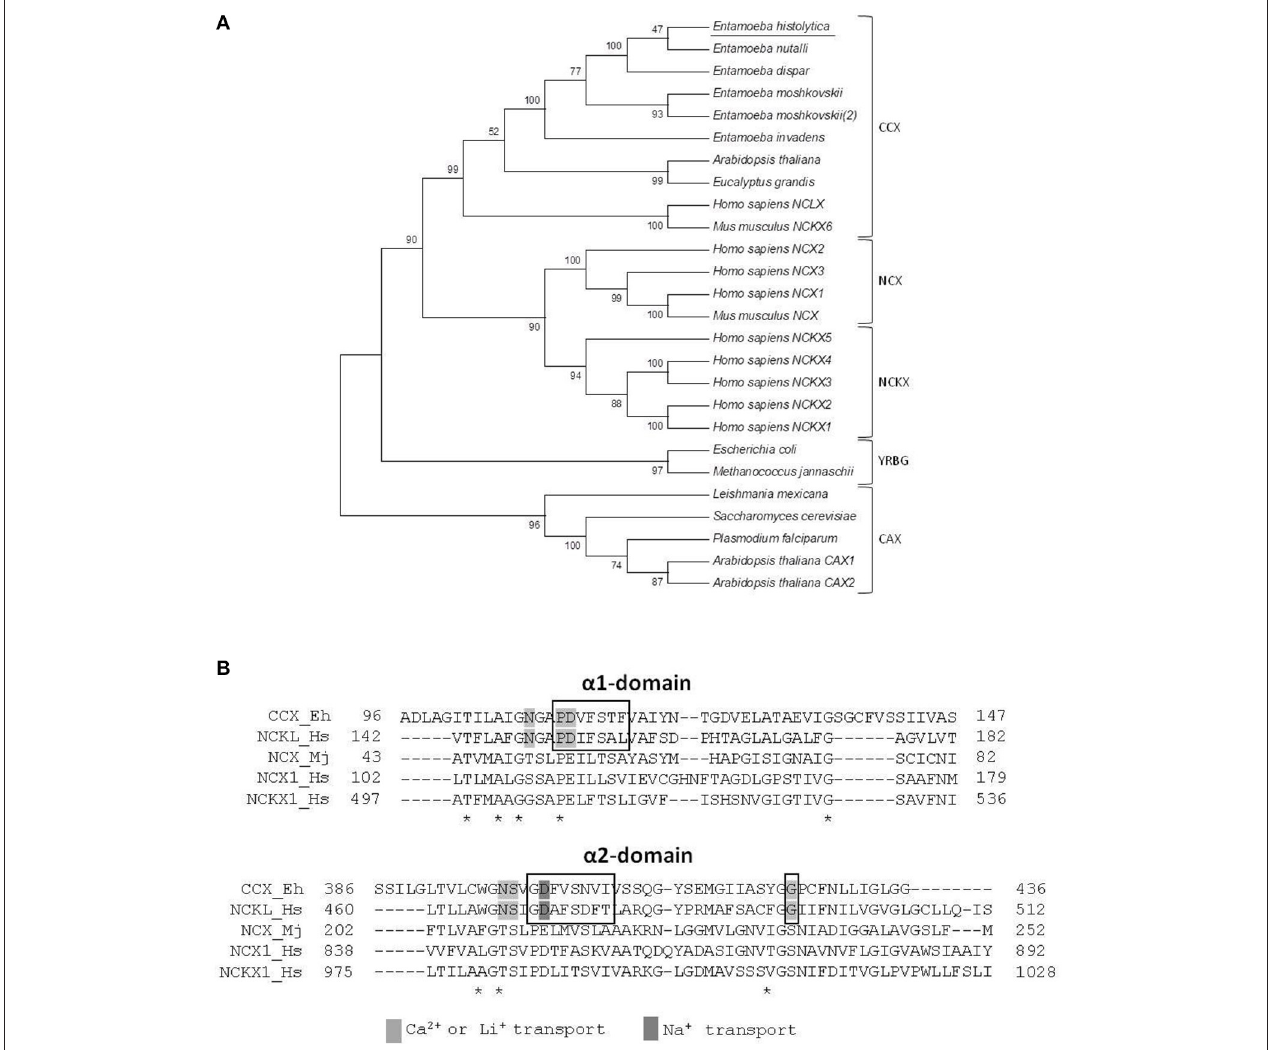
FIGURE 2 | Phylogenetic analysis of the E. histolytica exchanger. (A) The predicted amino acid sequence of the E. histolytica exchanger was aligned by ClustalW with sequences of several calcium/cation exchangers from different organisms and data were submitted to phylogenetic analysis by UPGMA using the MEGA 5.05 software package. The protein sequences used for this analysis were: E. histolytica (accession number, EHI_001770); E. nutalli (ENVI_134420); E. dispqr (EDI_138590); E. invadens (EIN_083040); E. moshcovskii (EMO_063580 and EMO_049830); Homo sapiens NCXL (NP_079235.2), NCKX 1-5 (NP_004718.1, NP_065077.1, NP_065740.2, NP_705932.2, and NP_995322.1), and NCX1-3 (NP_066920.1, NP_055878.1, and NP_150287.1); Mus musculus NCKX6 (NP_573484.2) and NCX (AAB69167.1); Arabidopsis thaliana NCKX (NP_197288.1), and CAX1-2 (NP_181352.1 and NP_566452.1); Eucalyptus grandis CCX (XP_010054949.1); Trichomonas vaginalis CAX (XP_001582908.1); Plasmodium falciparum CAX (SCP05226.1); Leishmania Mexicana CAX (XP_003873397.1); Saccharomyces cerevisiae CVX1 (NP_010155.1); Escherichia coli NCX (WP_000922901.1); and Methanococcus jannaschii NCX (3V5S_A). Numbers at the branch nodes indicate the confidence percentages of the tree topology from bootstrap analysis of 1000 replicates. Proteins are grouped as cation/Ca 2 + exchangers (CCX), Na + /Ca 2 + exchangers (NCX), Na + /Ca 2 + + K + exchangers (NCKX), bacterial exchangers (YRGB), and H + /Ca 2 + exchangers (CAX). (B) Amino acid sequence alignment of the α 1 and α 2 repeats of the E. histolytica exchanger with those of representative members of the different exchanger families. Asterisks indicate identical residues in all sequences. Boxes show the distinctive motives of the CCX family. Residues involved in calcium, sodium, or lithium transport are